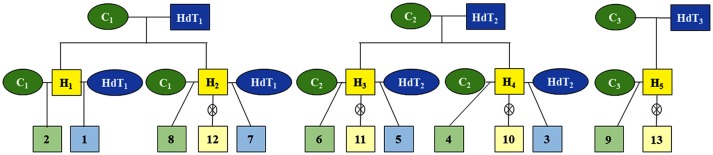
Heredogram of the 13 progenies of Coffea arabica from crosses between parents of the Catuaí group and Híbrido de Timor (HdT); C1, C2, and C3, genotypes Catuaí amarelo IAC 30, IAC 86, and IAC 64, respectively; HdT1, HdT2, and HdT3, genotypes Híbrido de Timor UFV 445-46, UFV 440-10, and UFV 530, respectively; H1, H2, H3, H4, and H5, hybrids from crosses between the parents Catuaí amarelo and Híbrido de Timor; 1, 3, 5, and 7, progenies of first rust-resistant backcross generation; 2, 4, 6, 8, and 9, progenies of first rust-resistance backcross generation; 10, 11, 12, and 13, progenies in the F2 generation.